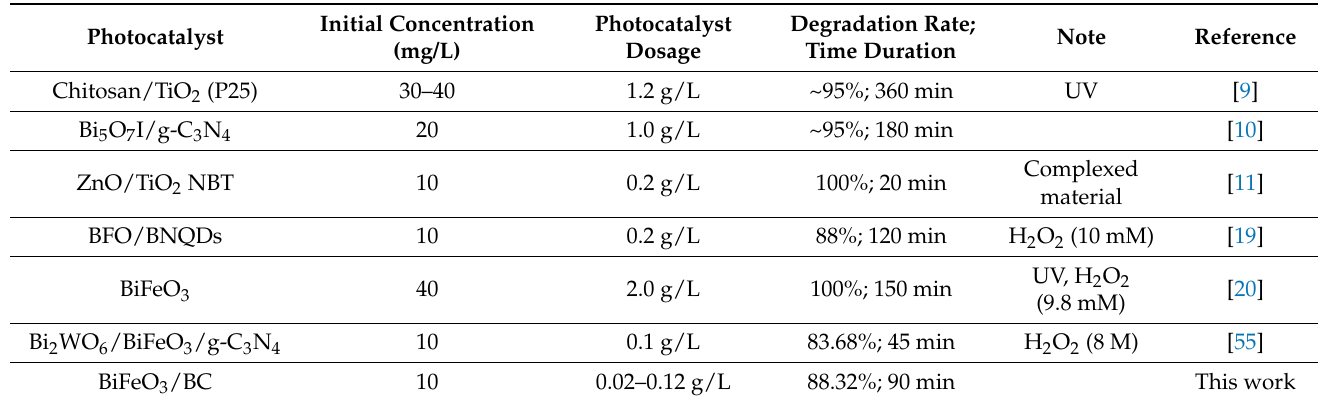
Table 1. TCH degradation efficiency comparison of different